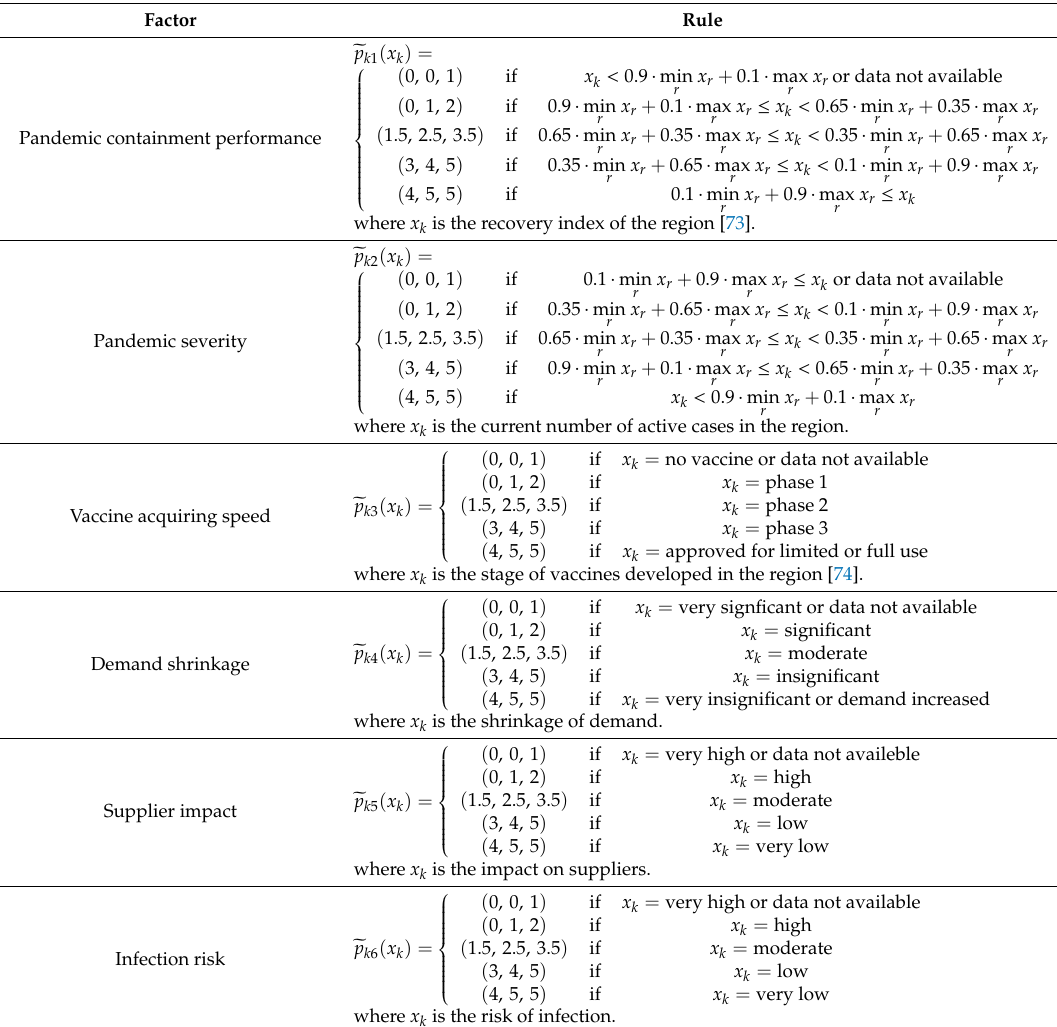
Table 4. Rules for evaluating the